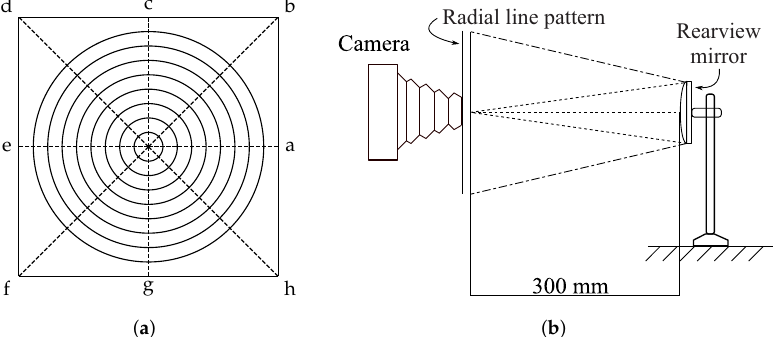
Figure 2. Setup to perform the distortion measurement according to JIS-554321 standard: ( a ) radial line pattern and ( b ) lateral-view